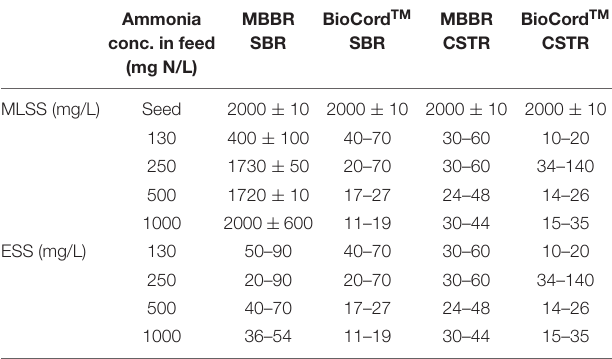
TABLE 2 | Mixed liquor suspended solids (MLSS) and Effluent suspended solids (ESS) in the fixed-film and hybrid bioreactors. Ammonia conc. in